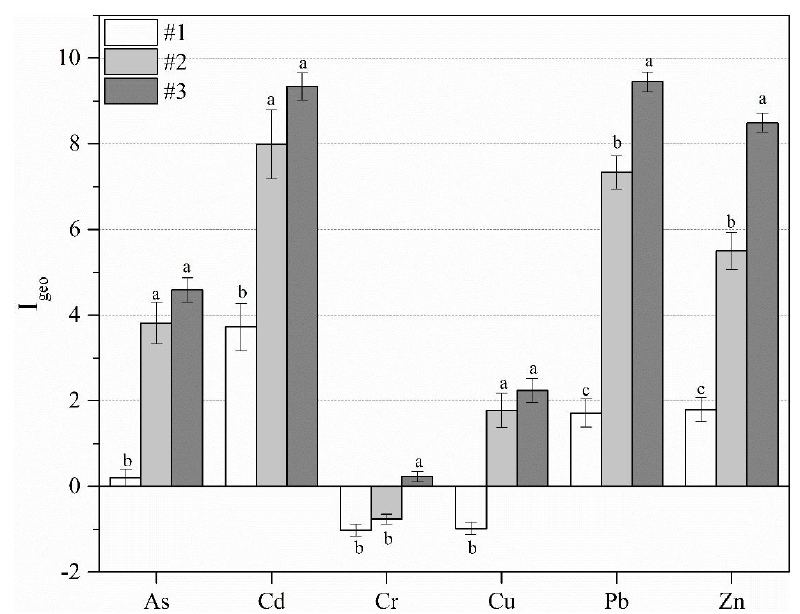
Figure 4. Difference of geo-accumulation index (I geo ± SD) and statistical test ( p < 0.05) between three abandoned sites. Bars marked with same letter are not significantly different at p = 0.05.